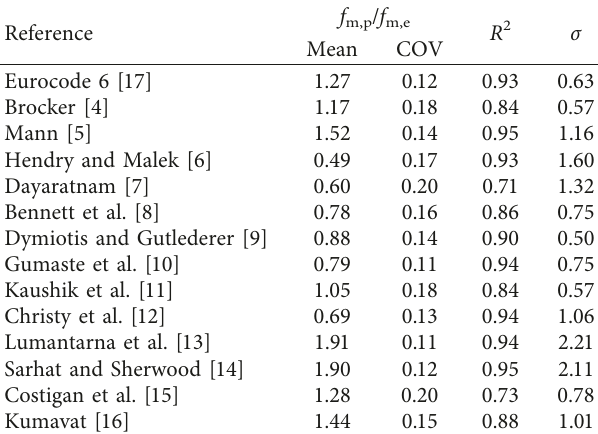
Table 8: Comparison of present experimental data with analytical